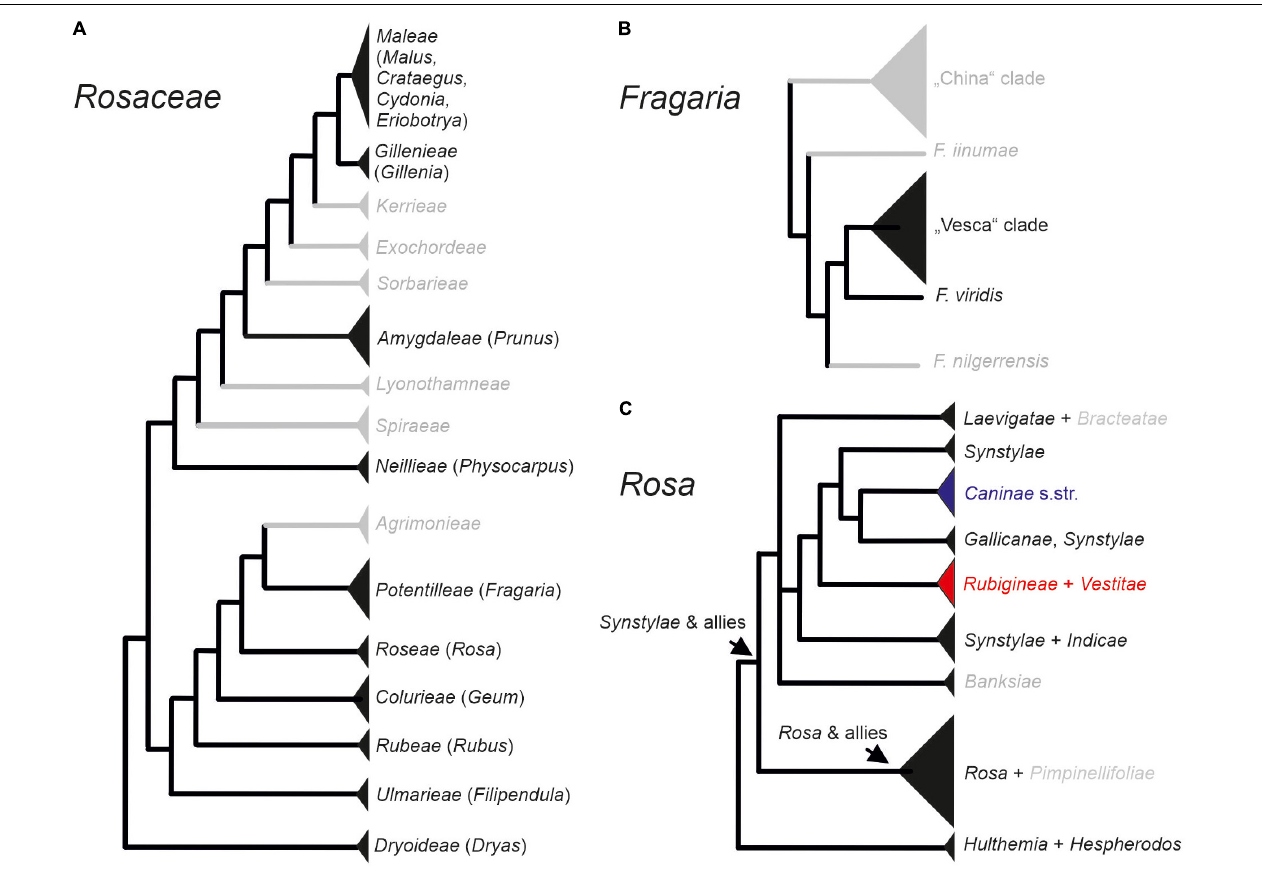
FIGURE 1 | Phylogenetic relationships at higher taxonomic levels within Rosaceae (A) , Fragaria (B) , and Rosa (C) . Within the genus Rosa , sect. Caninae represented by subsections Caninae (blue), Rubigineae , and Vestitae (red) form a separate data set for the analysis. Taxa depicted in gray were not represented in our